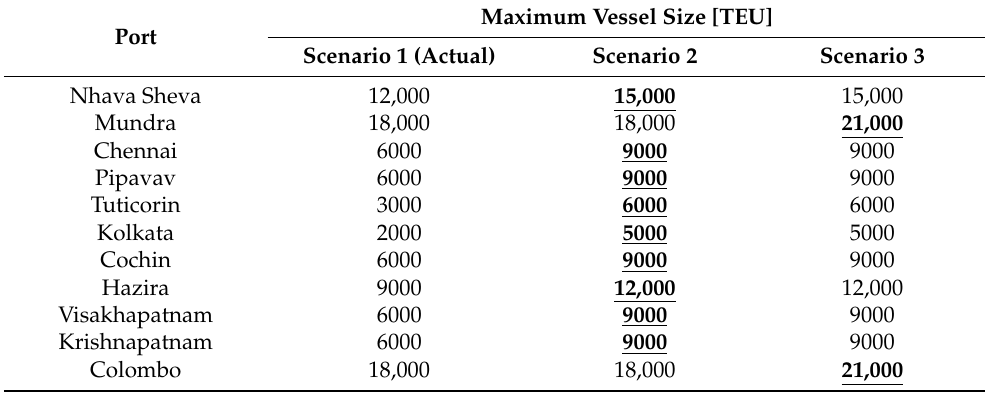
Table 4. Scenarios for maximum vessel size for each